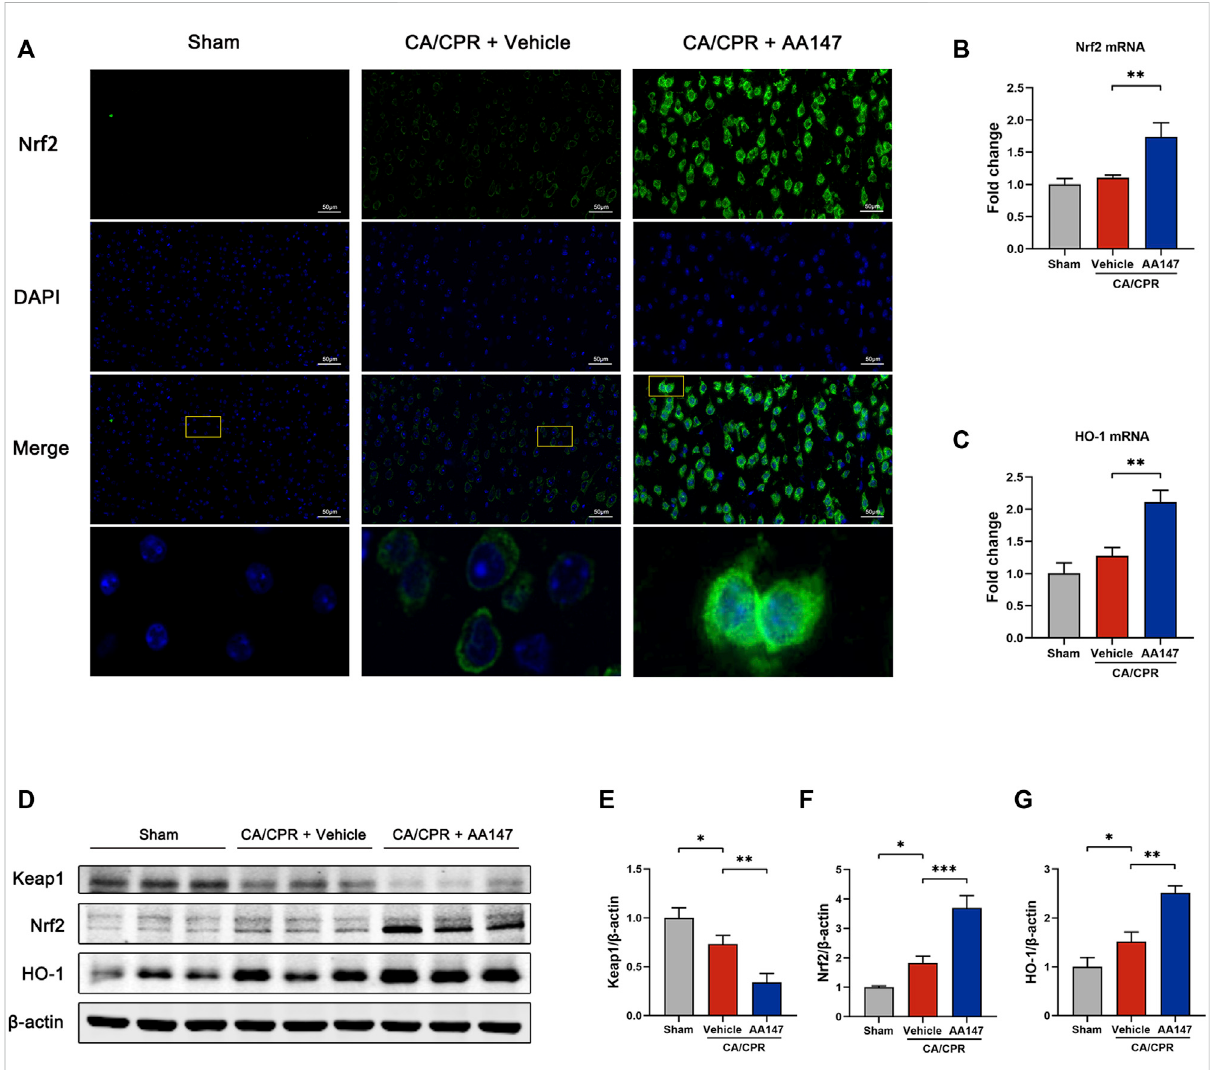
FIGURE 6 Nrf2 signaling pathway was activated by AA147 in neurons after cardiac arrest and cardiopulmonary resuscitation (CA/CPR). The brain tissue samples of mice ineach group were collected at 1day after CA/CPRto detect the AA147-dependent activation of Nrf2. (A) Representative imagesof immuno fl uorescentstainingofNrf2(green)presentedthatAA147elevatedtheexpressionofNrf2andincreaseditsnuclearaccumulation.Scalebar= 50 μ m. (B) The mRNA levels of Nrf2 and (C) HO-1 were examined by qPCR. (D) Western blot analysis of (E) Keap1, (F) Nrf2, and (G) HO-1. Data are displayed as mean ± SD ( n = 3). * p < 0.05. ** p < 0.01. *** p <